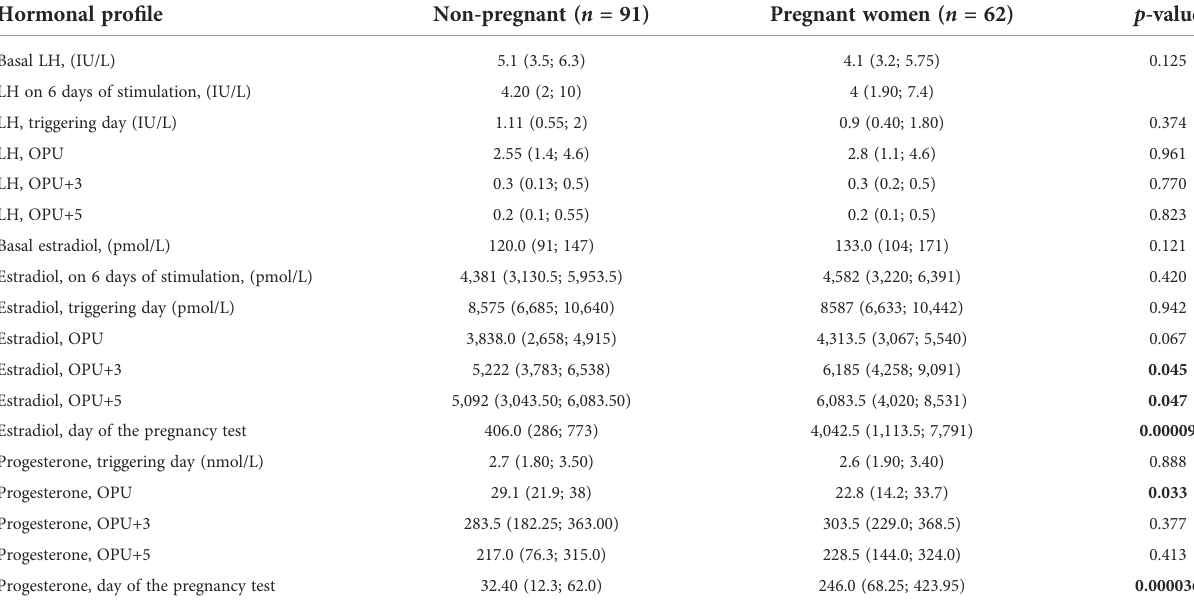
TABLE 4 LH, estradiol, and progesterone concentrations in blood serum in pregnant and non-pregnant women. Hormonal pro fi le